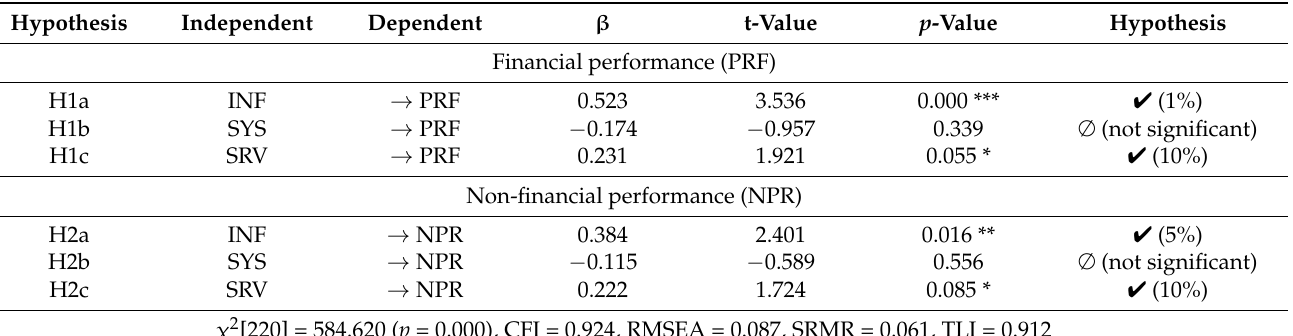
Table 4. Hypotheses